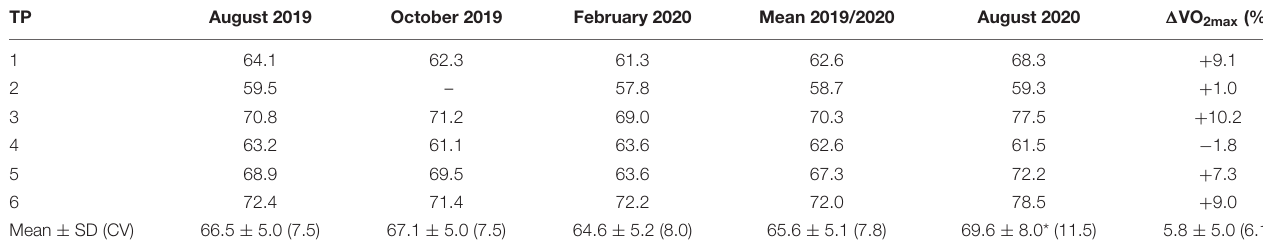
TABLE 3 | Development of VO 2max (ml · kg − 1 · min − 1 ).